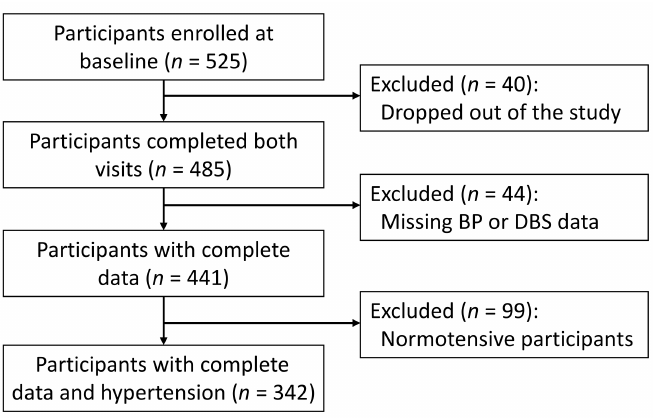
Figure 1. Flow chart of the analytical